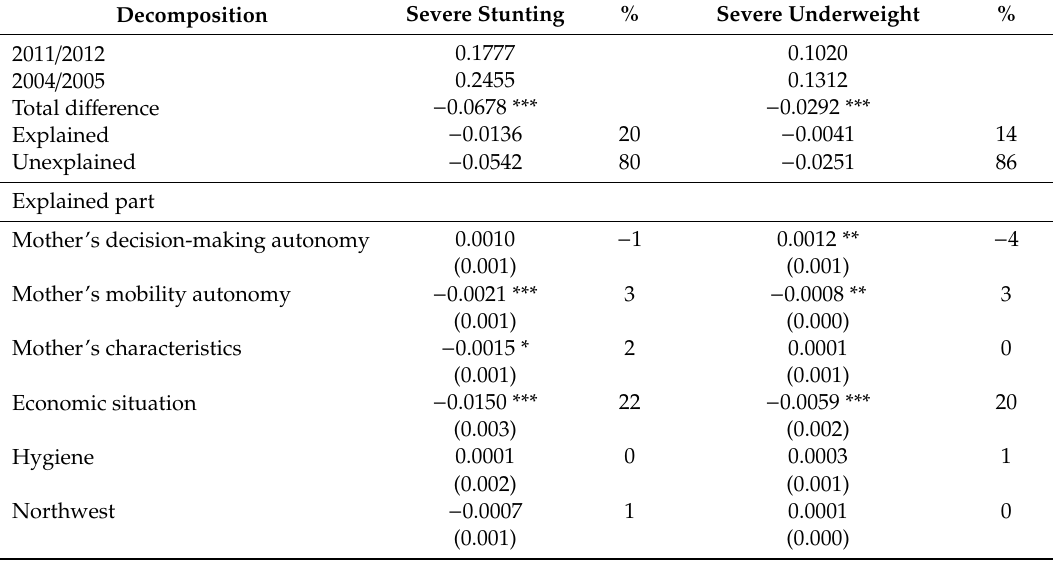
Table 6. Non-linear decomposition of socio-economic di ff erences in severe stunting and severe underweight among Indian children under five: IHDS 2004 / 2005–2011 /